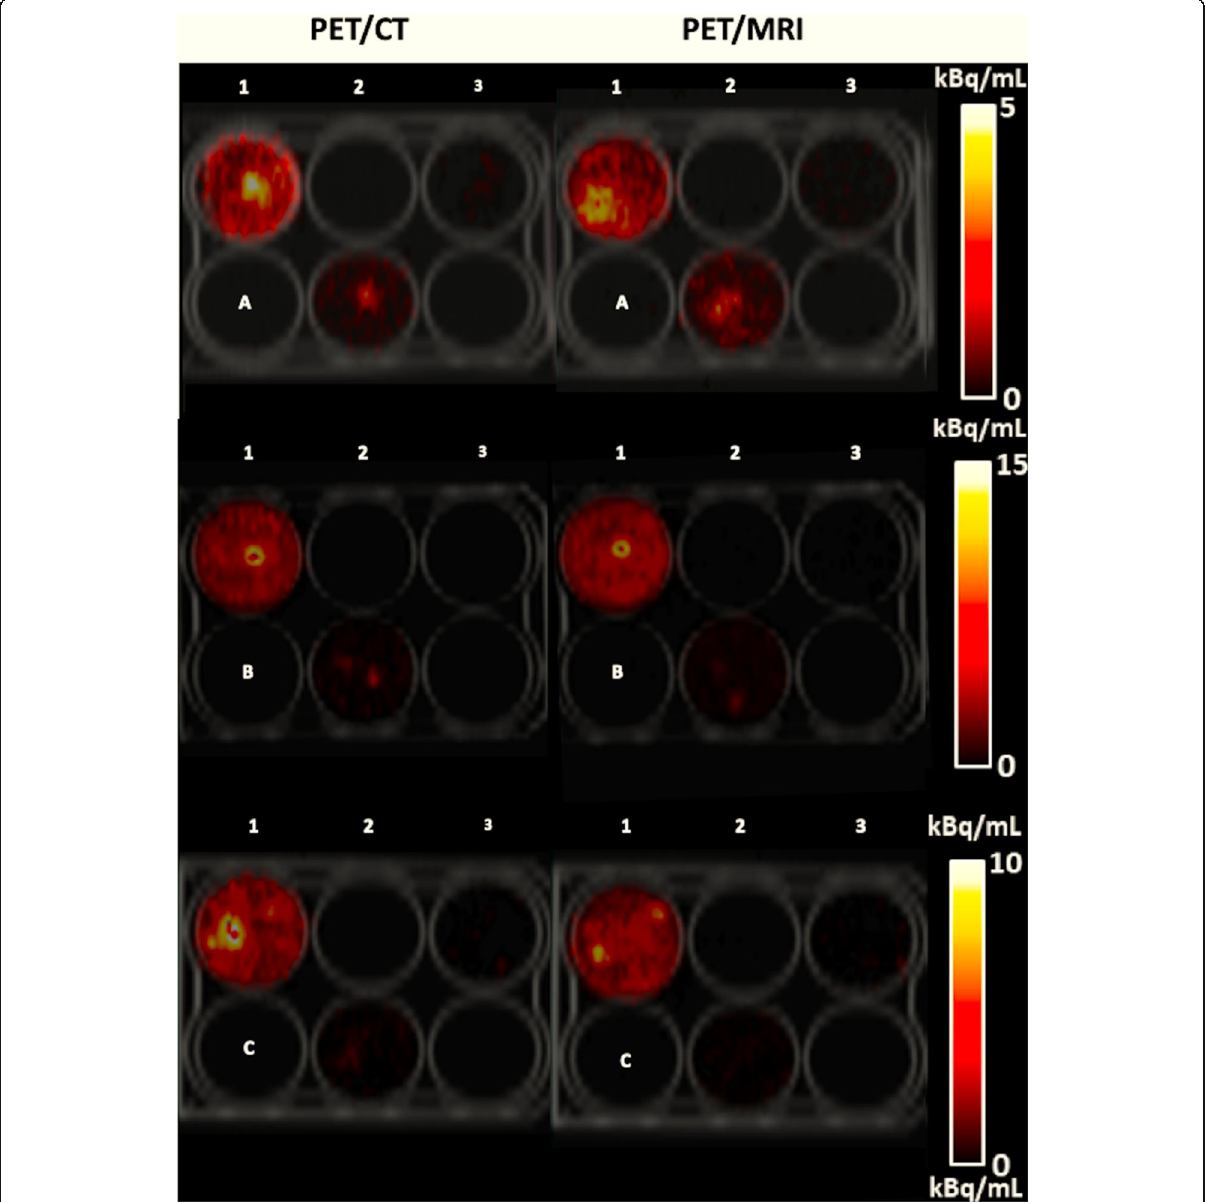
Fig. 4 PET images of 6-well plates containing 89 Zr-labeled Jurkat cells acquired using PET/CT and PET/MRI together with their corresponding co- registered CT image. Cell numbers and specific activities per well (kBq/10 6 cells; indicated parenthetically) were as follows: (A1) 1.36 × 10 6 cells (2.70). (A2) 5.20 × 10 5 cells (2.18). (A3) 1.45 × 10 5 cells (1.57). (B1) 3.83 × 10 5 cells (31.91). (B2) 6.75 × 10 4 cells (27.77). (B3) 1.00 × 10 4 cells (18.37). (C1) 8.45 × 10 5 cells (7.83). (C2) 1.65 × 10 5 cells (3.57). (C3) 6.10 × 10 4 cells